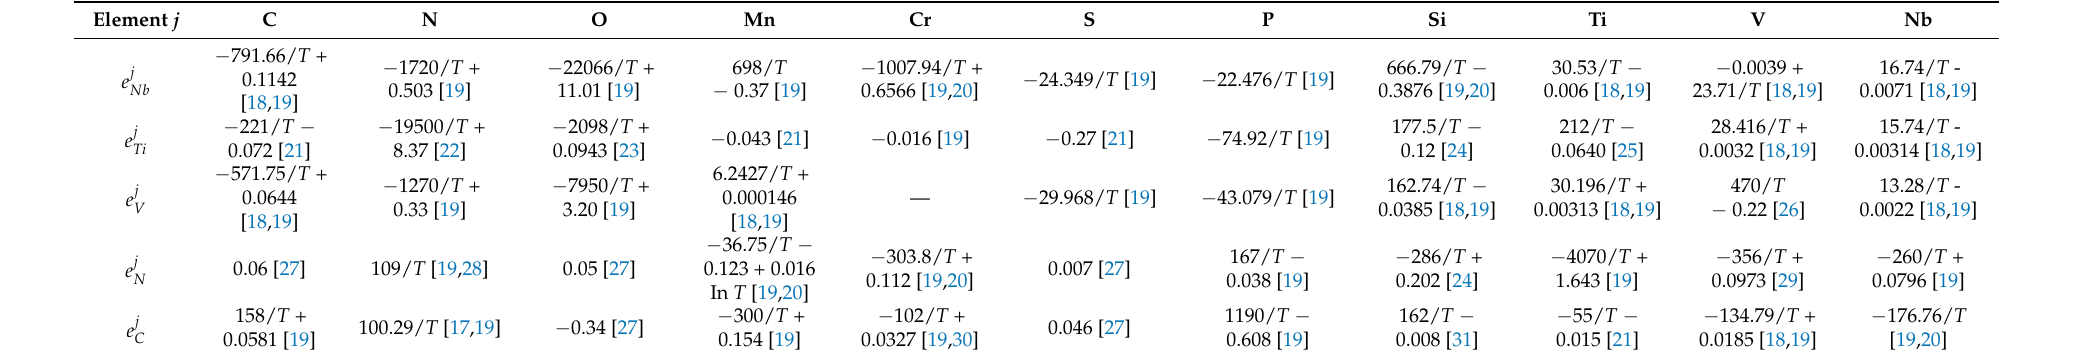
Table 2. Selected interaction activity coefficient in dilute solutions of